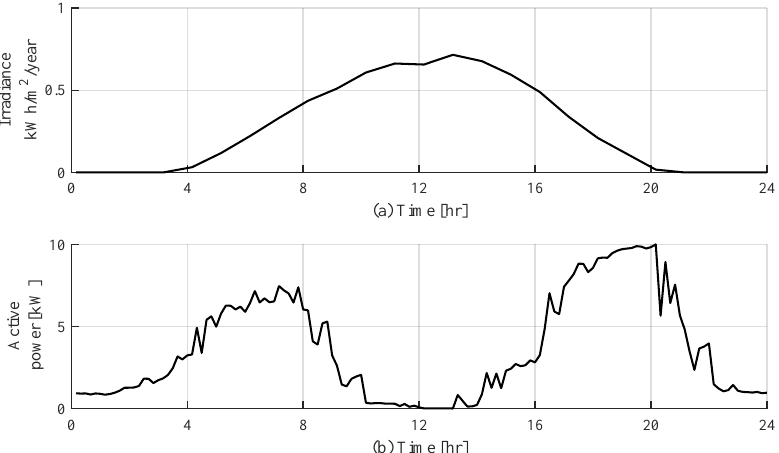
Figure 4. Plot of ( a ) typical solar irradiation on a clear sky day and ( b ) typical power demand profile of a residential customer in the LV grid under